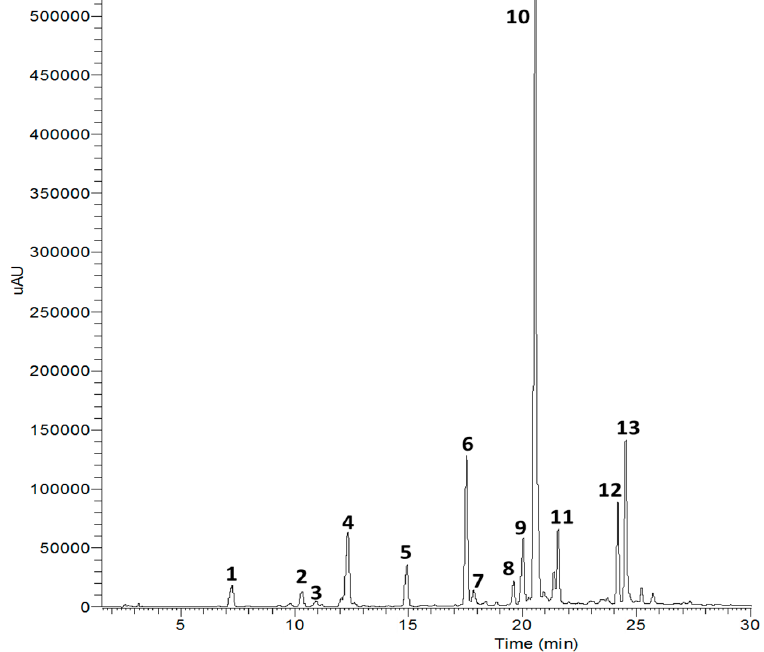
Figure 1. High performance liquid chromatography (254 nm) of compounds isolated from X. strumarium .